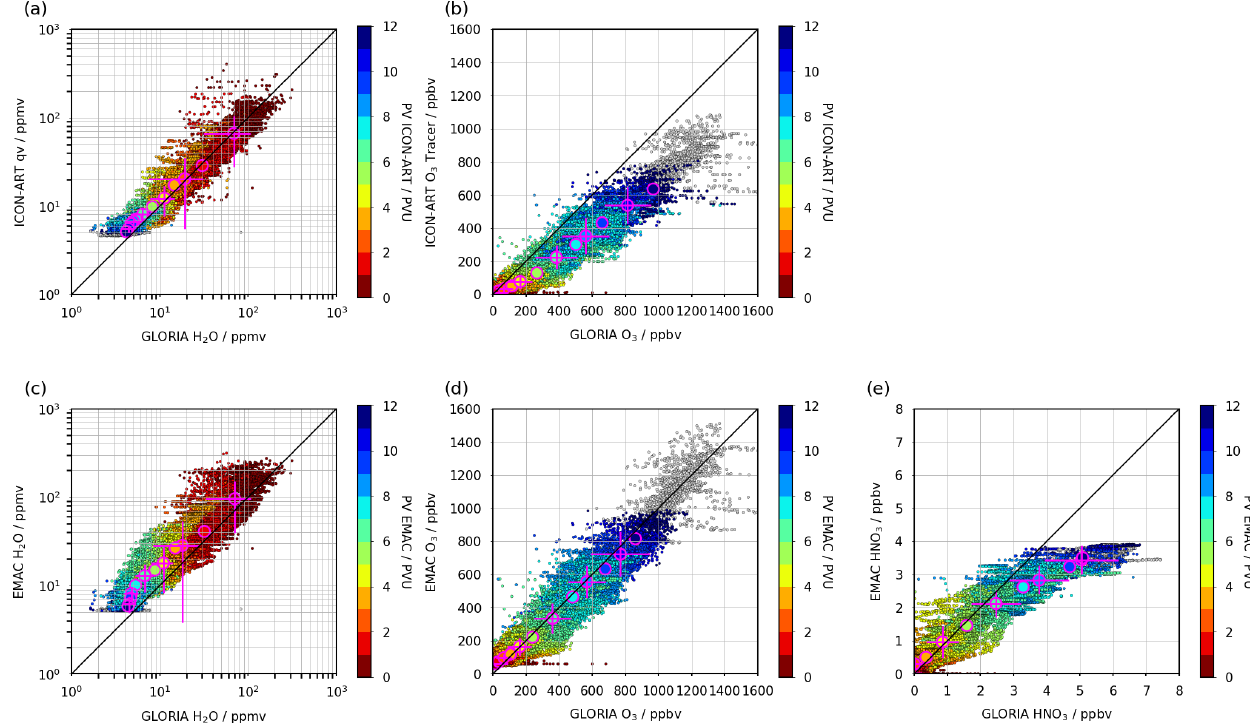
Figure 11. Correlation of GLORIA H 2 O, O 3 and HNO 3 to corresponding ICON-ART and EMAC output variables. The large data points framed in magenta are a binned representation of the small data points. Magenta bars indicate the standard deviation of the binned data points. Colour-coding: PV from corresponding